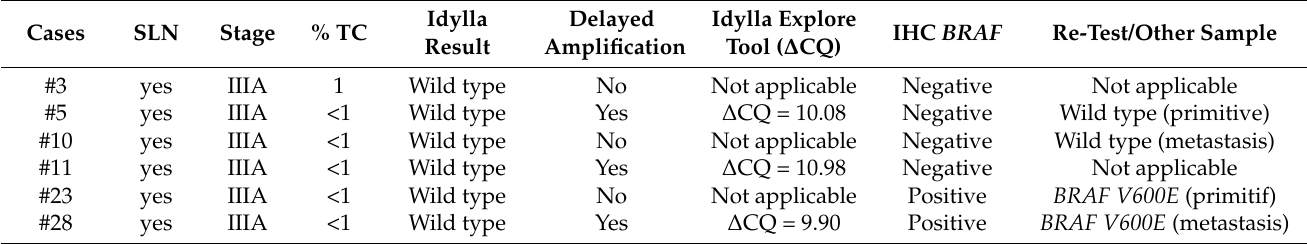
Table 4. Contribution of the Idylla Explore tool for cases at risk of false negative